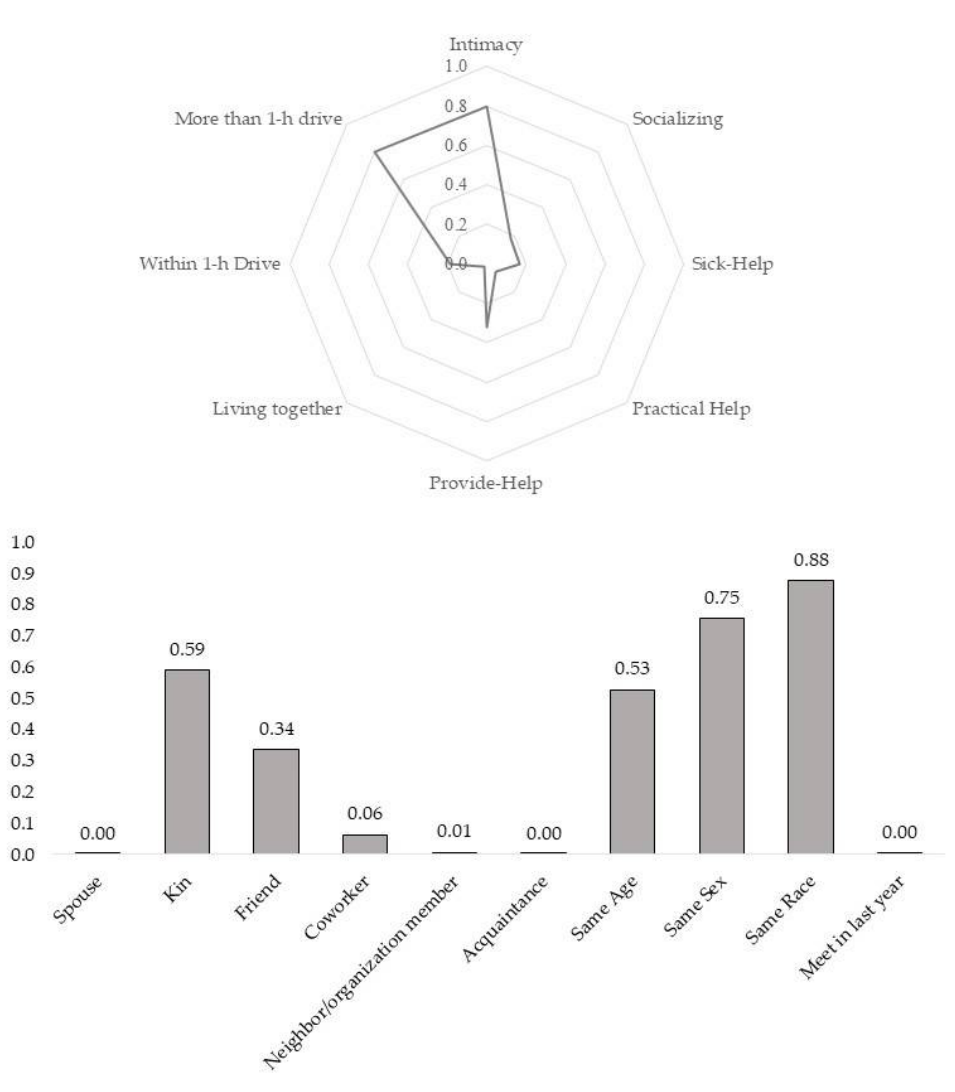
Figure 3. Remote type.